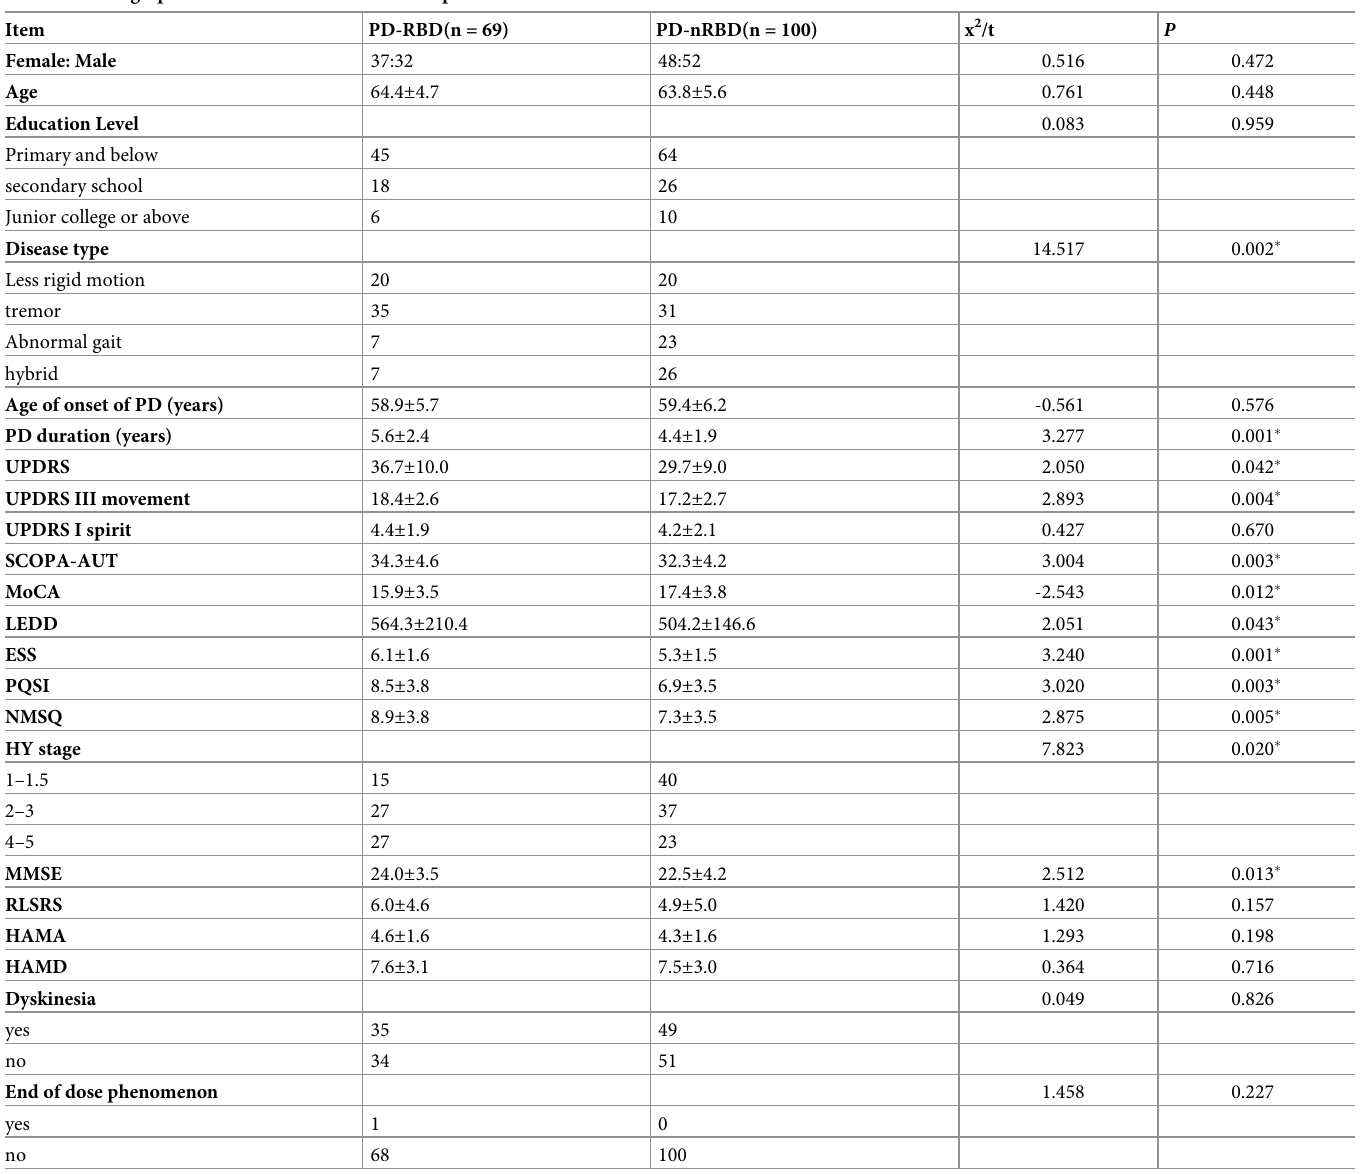
Table 1. Demographic and clinical characteristics of